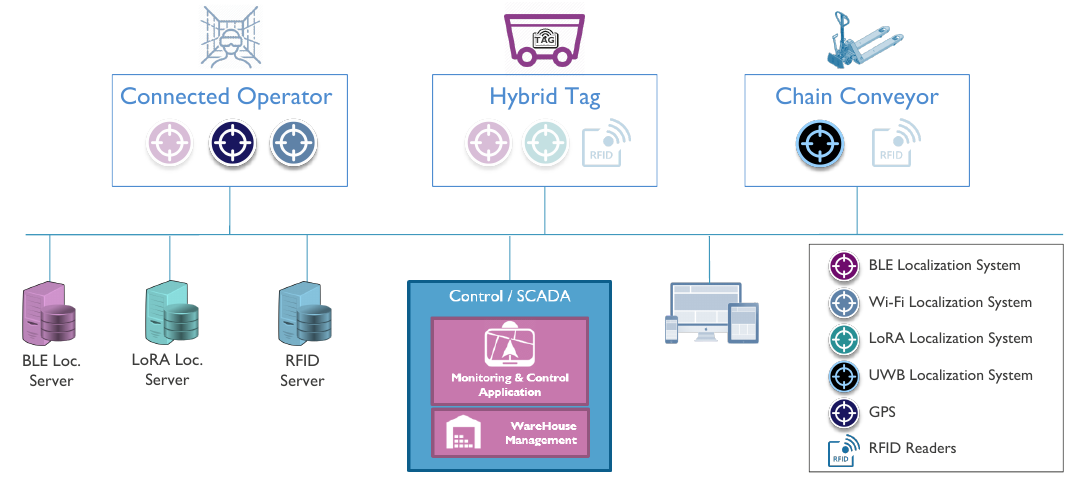
Figure 7. System architecture for the target use case.